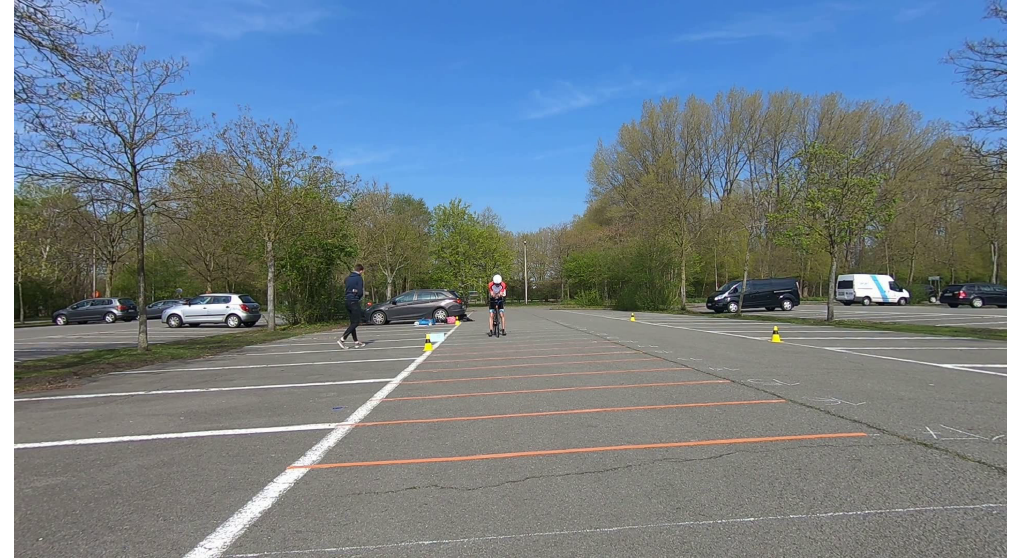
Figure 9. Example of static distance calculation test. The camera bicycle is placed at the 0 m mark, and the cyclist behind takes place at one of the other marks, each spaced 1 m apart.